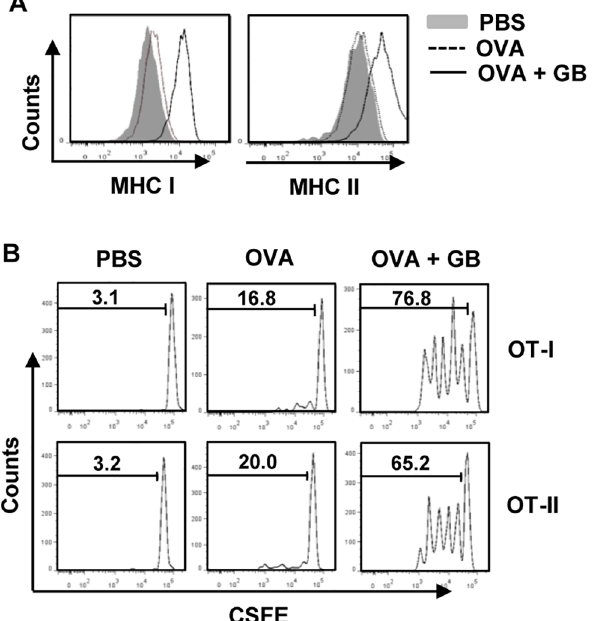
Fig 5. GB promotes antigen presentation and antigen-specific T cell proliferation in vivo . (A) Mice were injected with PBS, OVA or the combination of OVA and GB for 24 hours, and then expression levels of MHC class I and II were analyzed in lineage - CD11c + DCs in spleen. (B) Purified CD8 T cell from OT-I or isolated CD4 T cell from OT-II were labeled with CFSE and transferred into CD45.1 congenic mice, and 24 hours later, mice were further treated with PBS, OVA or the combination of OVA and GB. After 3 day treatment, splenocytes were stained with CD45.2 and OT-I or OT-II cell proliferation was determined by CFSE dilution in CD45.2 + cells. All data are from analyses of 6 individual mice each group (2 mice per experiment, total 3 independent experiments).